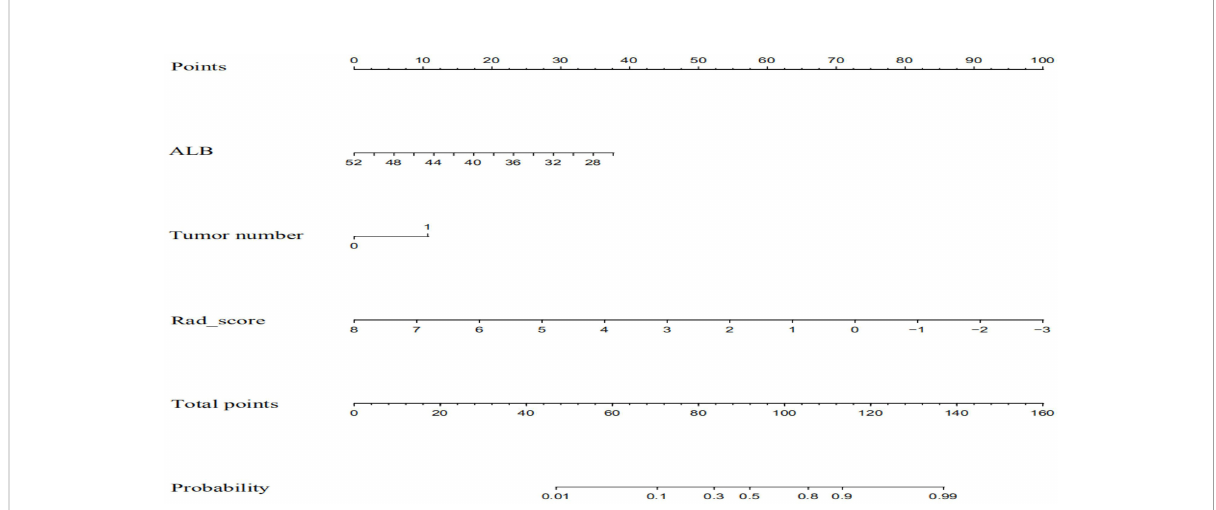
FIGURE 3 The combined nomogram incorporated ALB, tumor number, and the radiomics score. The nomogram is valued to obtain the probability of ER by adding up the points identi fi ed on the points scale for each variable albumin.